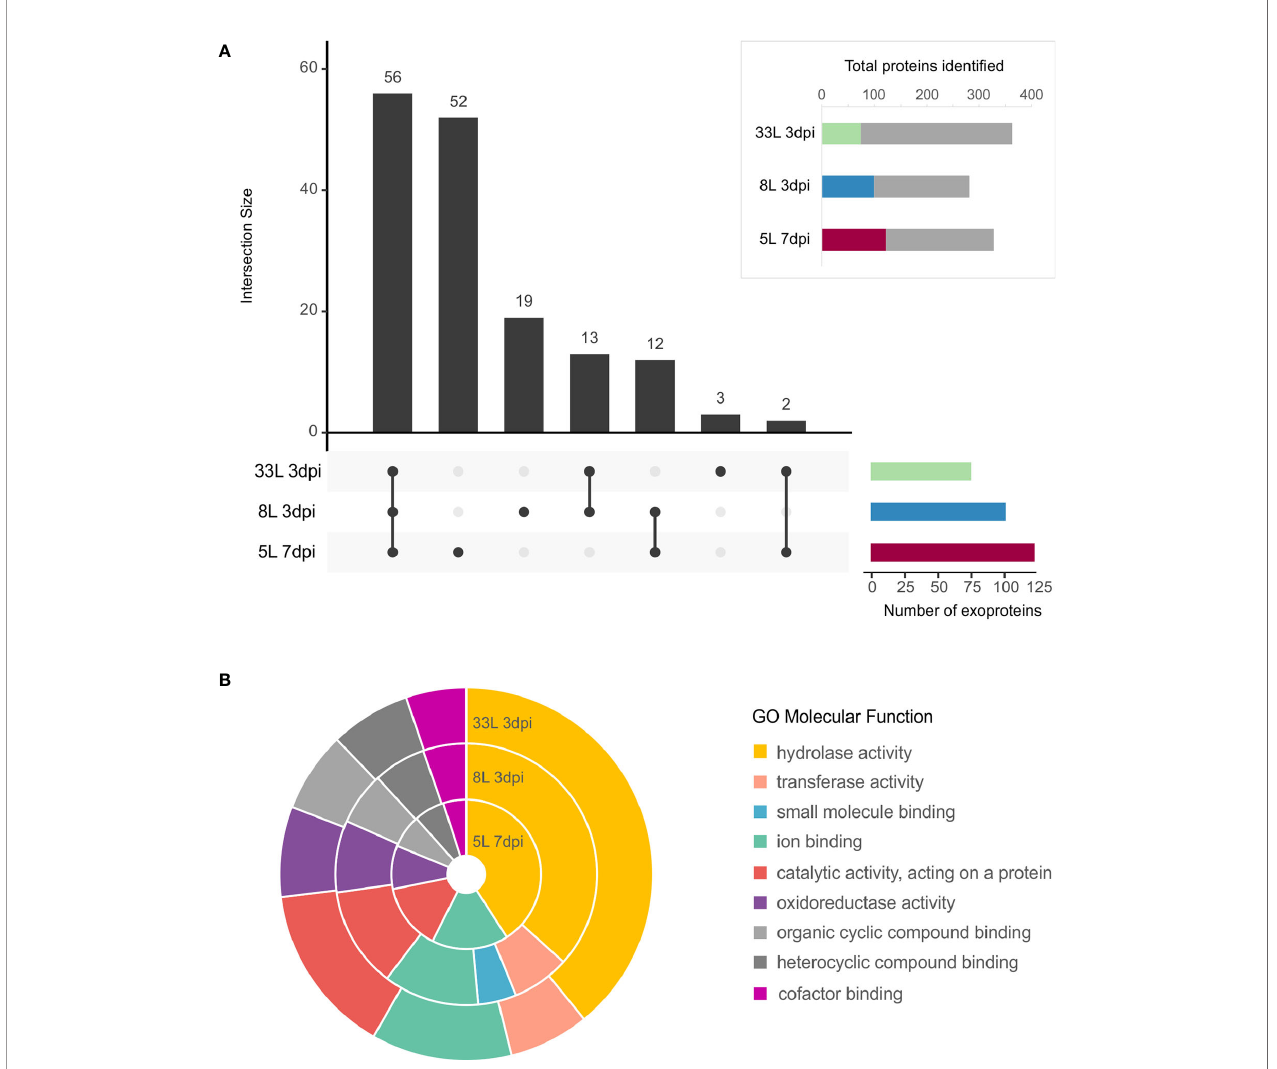
FIGURE 3 | Exoproteome of M. laxa isolates. (A, box) Proportion of identi fi ed M. laxa proteins with potential signal peptides detected in exoproteome for an early and late time point (3 and 7 dpi, respectively) in 8L and 33L virulent isolates, and late time point (7 dpi) in 5L weak virulent isolate. (A) UpSet plot of intersecting sets of SignalP positive proteins found in exoproteomes. Total identi fi cations for each sample (left bar chart), were 74 proteins for 33L and 100 proteins for 8L at 3 dpi, and 122 for 5L at 7 dpi. The connected dots among protein sets shown in the lower panel and numbers indicated in the top bar chart represent the group of proteins shared between exoproteome samples. (B) Classi fi cation of SignalP positive proteins based on GO molecular function. Shown is the percentage (%) of proteins in exoproteome samples attributed to each GO group at level